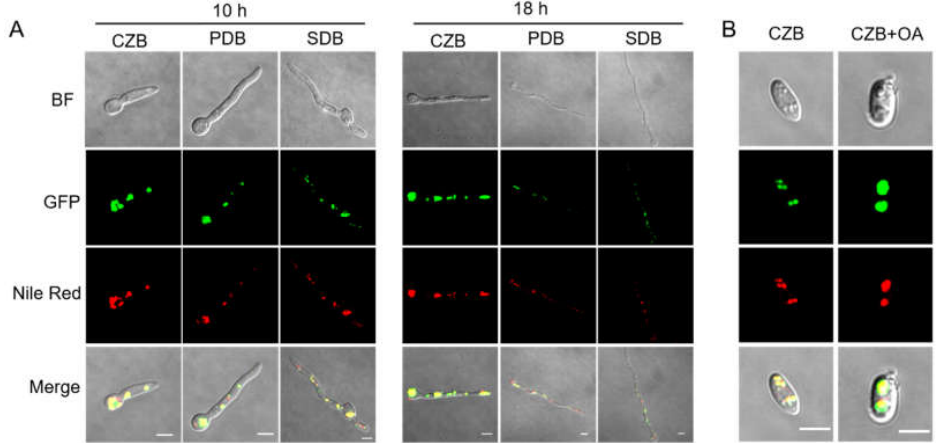
Figure 2. Representative images of BbPLin1 ::eGFP fusion protein expression and cellular localization. ( A ) B. bassiana harboring the PBbPlin1::eGFP construct was cultured in indicated media (CZB/PDB/SDB) for 10 and 18 h, after which fungal cells were counter–stained with Nile Red. ( B ) Effects of oleic acid on lipid droplet (LD) formation. B. bassiana PBbPlin1::eGFP conidia were cul- tured in CZB and CZB + 0.25% oleic acid for 4 d before visualization of cells using fluorescent con- focal microscopy. BF: bright field. Size bar = 5 μm.